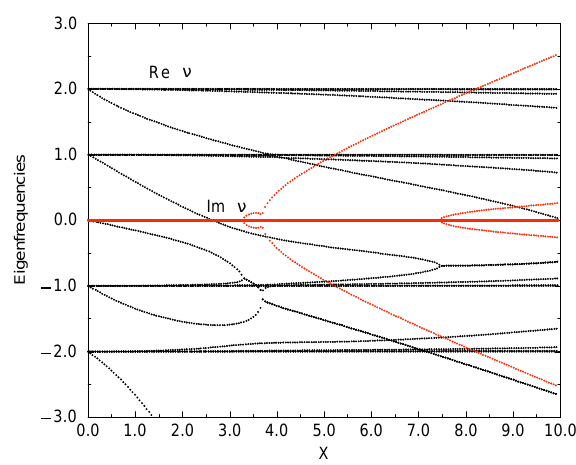
FIG. 4. (Color) Eigenfrequencies (real parts in black, imaginary in red) of transverse oscillations versus (cid:88) (cid:173) (cid:78)(cid:101) (cid:50) b (cid:87) (cid:121) (cid:50) p (cid:50) g (cid:109)(cid:99) (cid:50) (cid:84) (cid:48) . The parameter (cid:80) s (cid:173) (cid:53) . modes for a small current have zero oscillations of the dipole moment over an angle in the synchrotron phase